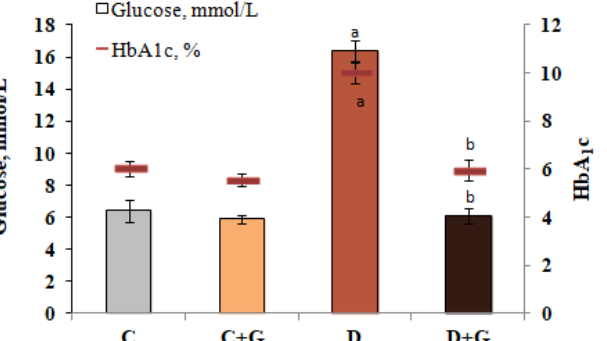
Figure 2. The effect of Galega officinalis extract on the content of glucose and glycosylated hemoglobin in normal and DM conditions (Hereinafter: control animals (C); control animals that were treated with an extract of Galega officinalis at a dose of 600 mg/kg per day (C + G); animals with diabetes mellitus (D); animals with diabetes that were treated with an extract of Galega officinalis at a dose of 600 mg/kg per day (D + G)). a — p < 0.05, as compared with the control group; b — p < 0.05, as compared with the diabetes mellitus group.